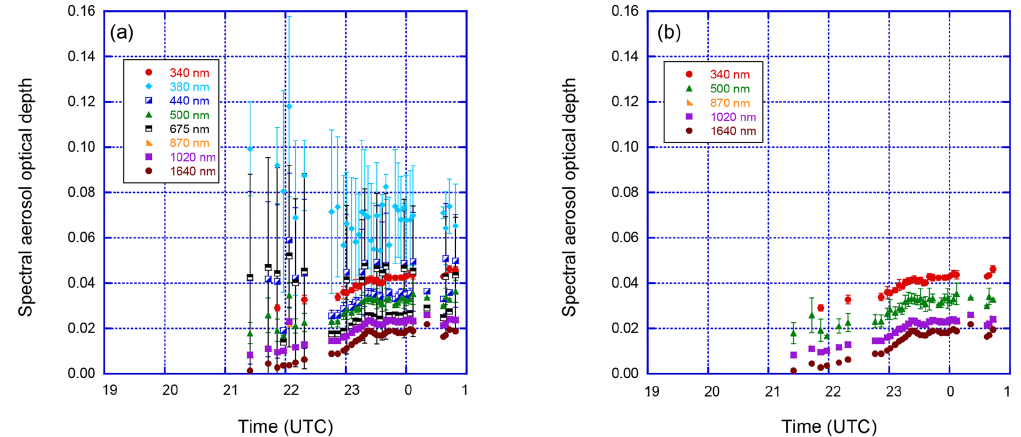
Figure 15. Spectral AOD exhibiting large triplet variability at PEARL (lat 80.05, long − 86.42) on 25 August 2013. (a) Version 3 Level 1.5 cloud-screened-only data are plotted with large triplet variability and these data were not removed by the cloud screening. The error bars represent the triplet variability (AOD max–AOD min) divided by 2 so the full range represents the AOD triplet variability. The large triplet variability occurs mainly at shorter wavelengths than 675nm. (b) Data affected by large triplet variability (i.e., AOD 380nm, AOD 440nm, and AOD 675nm) are removed by using the Level 1.5 large triplet variability quality